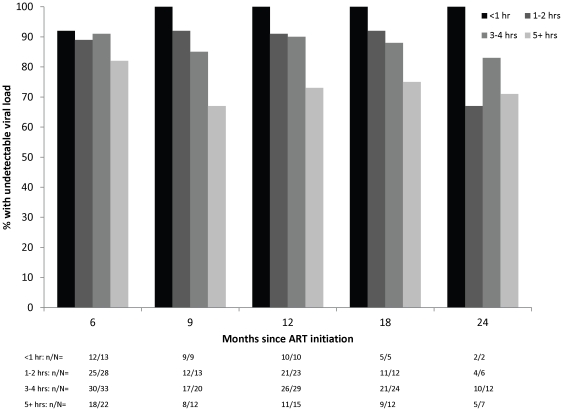
Percentage of children achieving viral suppression after 6 months of ART, by travel time.